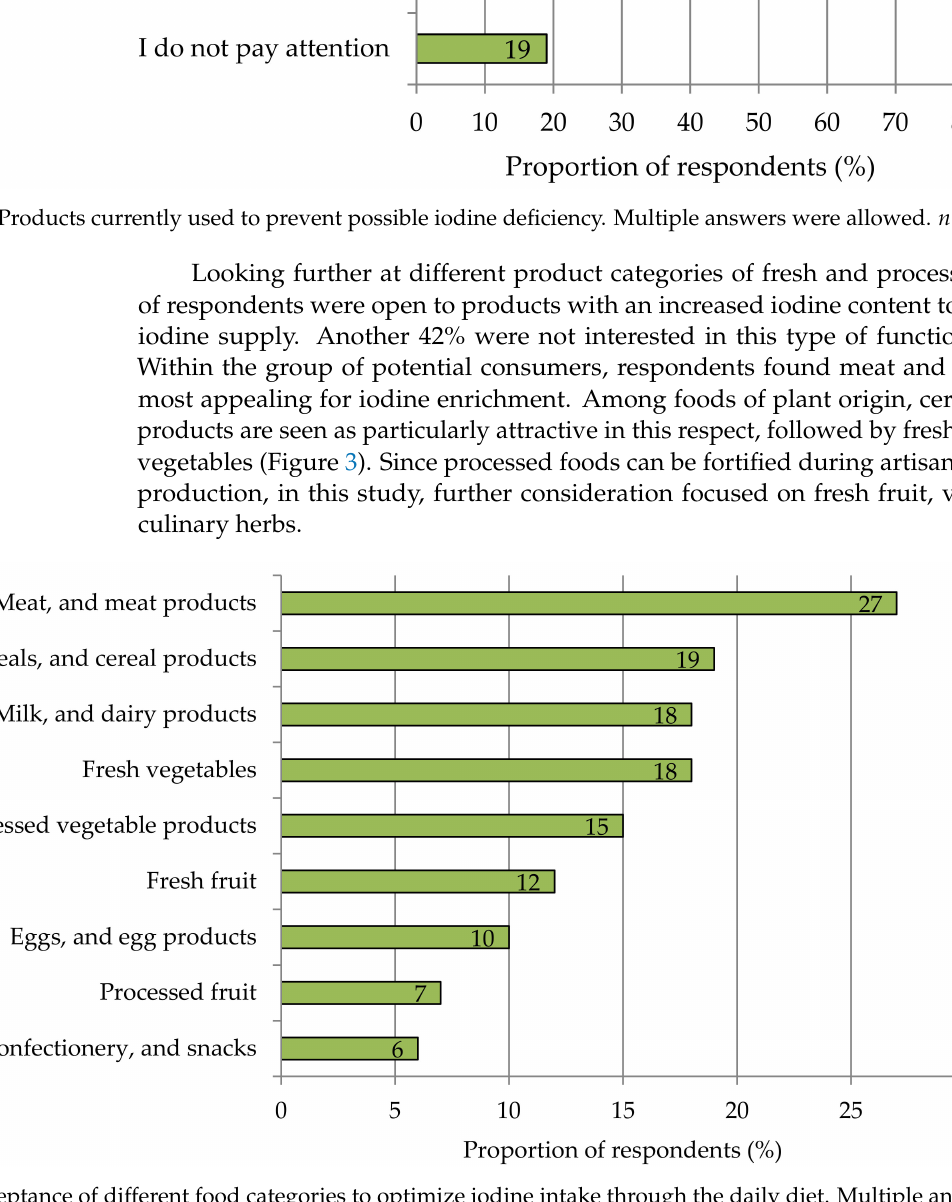
Figure 3. Acceptance of different food categories to optimize iodine intake through the daily diet. Multiple answers were allowed. n =